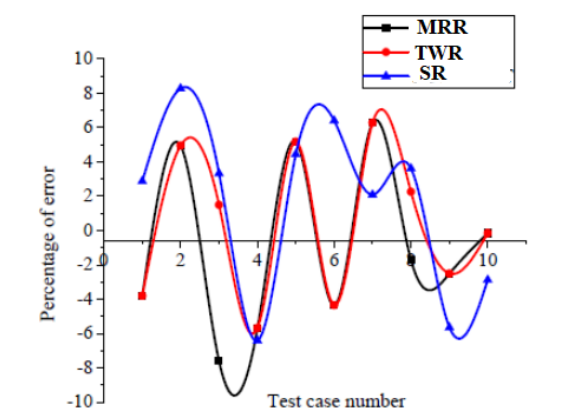
Fig. 8. Graph showing the percentage deviation in prediction of the responses during EDM